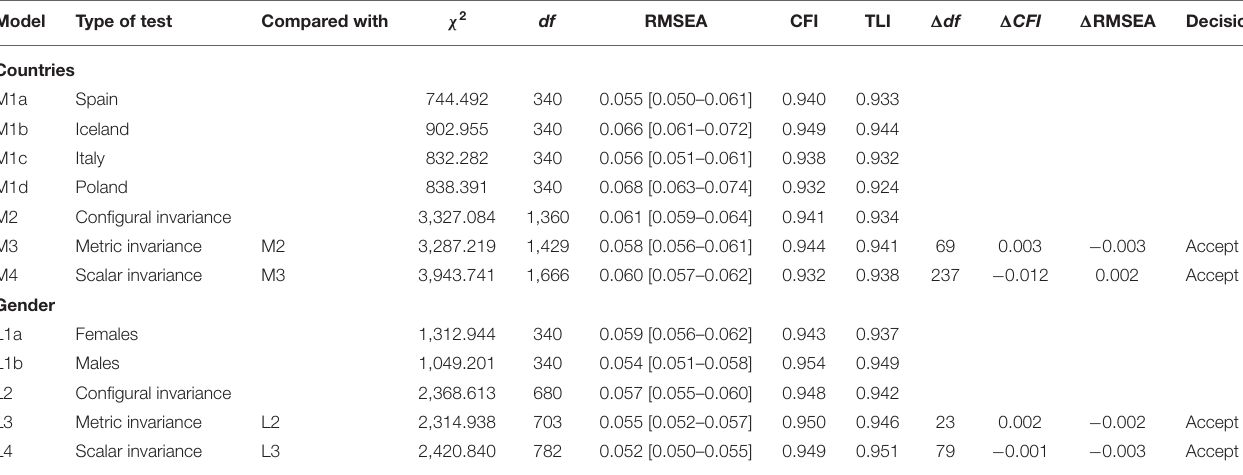
TABLE 1 | Evaluations of multigroup confirmatory factor analysis measurement invariance (MGCFA MI; N = 1,546).